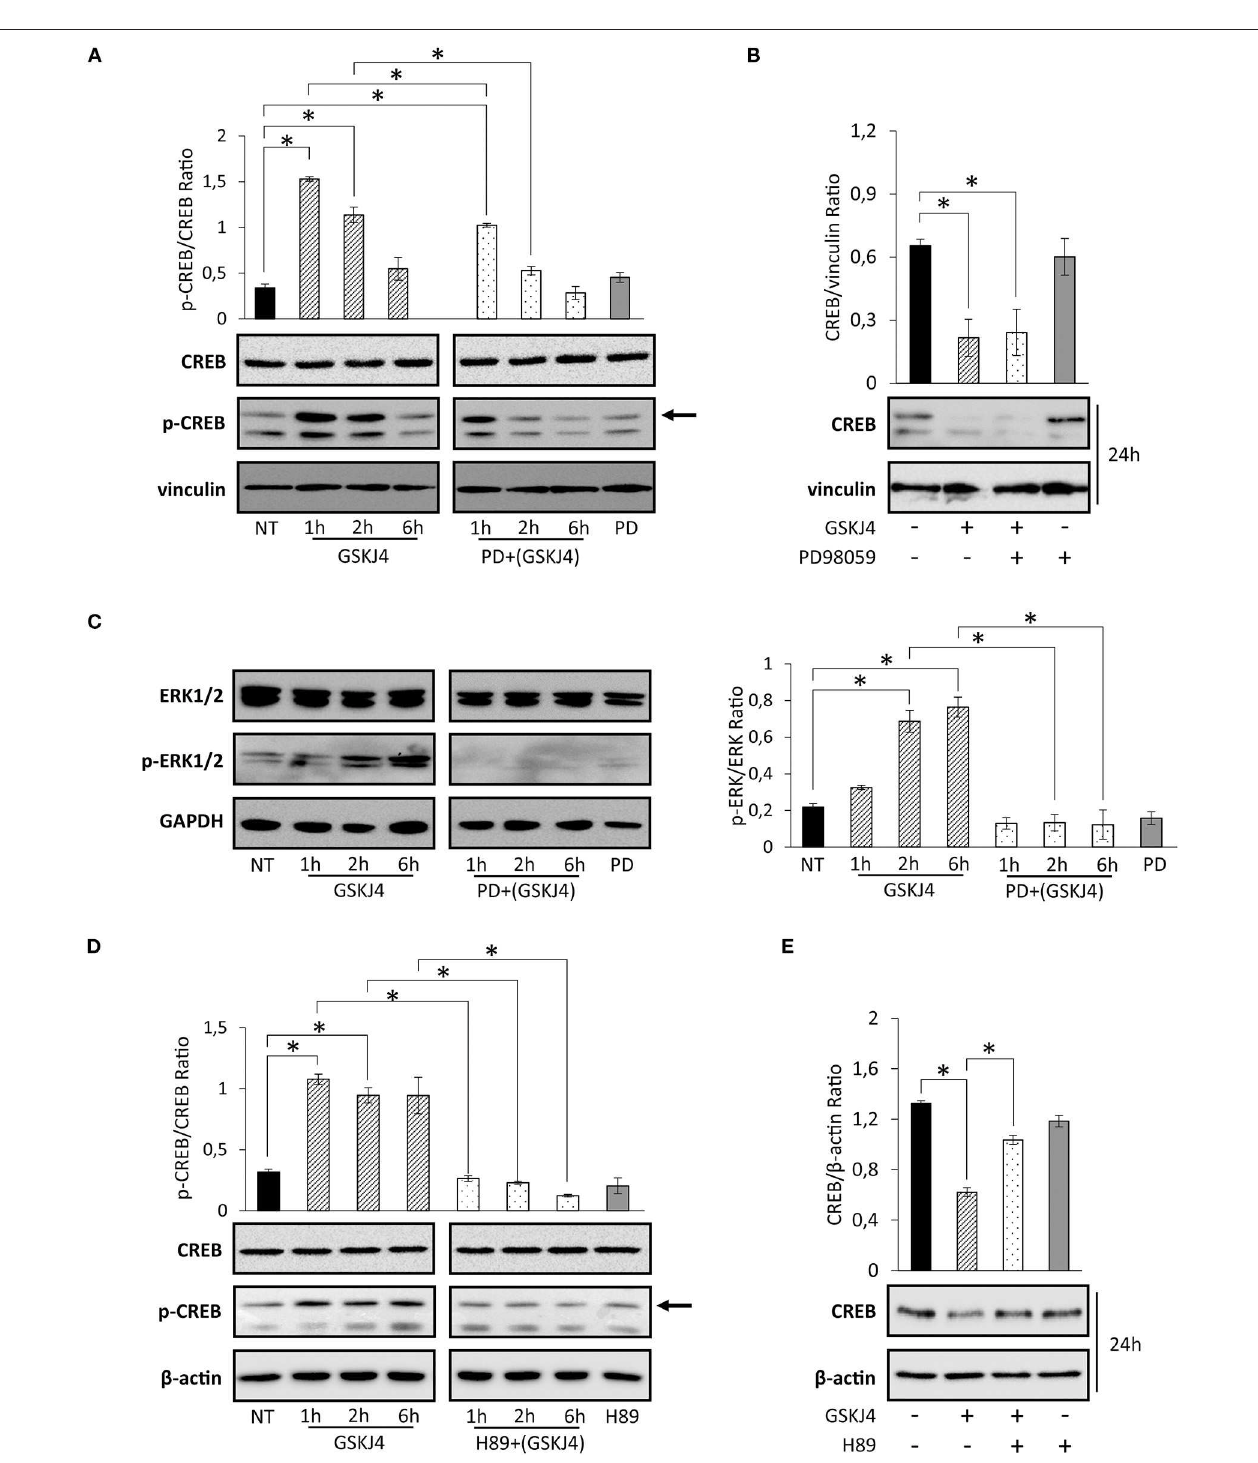
FIGURE 4 | Effects of PD98059 and H89 on GSKJ4-mediated Ser133 phosphorylation induction and cAMP response element-binding (CREB) protein decrease. U-937 cells were treated up to 24h with 10 µ M GSKJ4 in the presence or in the absence of 10 µ M PD98059 or 20 µ M of H89. Immunoblotting analyses of CREB and phospho-Ser133-CREB were performed after 2, 4, and 6h of treatment with GSKJ4 alone and in combination with PD98059 (A) or H89 (D) . Untreated (NT), PD98059 and H89 lines refer to 2h of treatment. (C) ERK1/2 and phospho-ERK1/2 levels were evaluated in the same experimental setting described for (A) . CREB protein levels and CREB/housekeeping protein Ratio were determined by Western blotting in response to 24h of treatment with GSKJ4 alone and in combination with PD98059 (B) or H89 (E) , respectively. All densitometric analyses shown in this figure were calculated from three distinct experiments. * P < 0.05 by ANOVA and unpaired t -test.